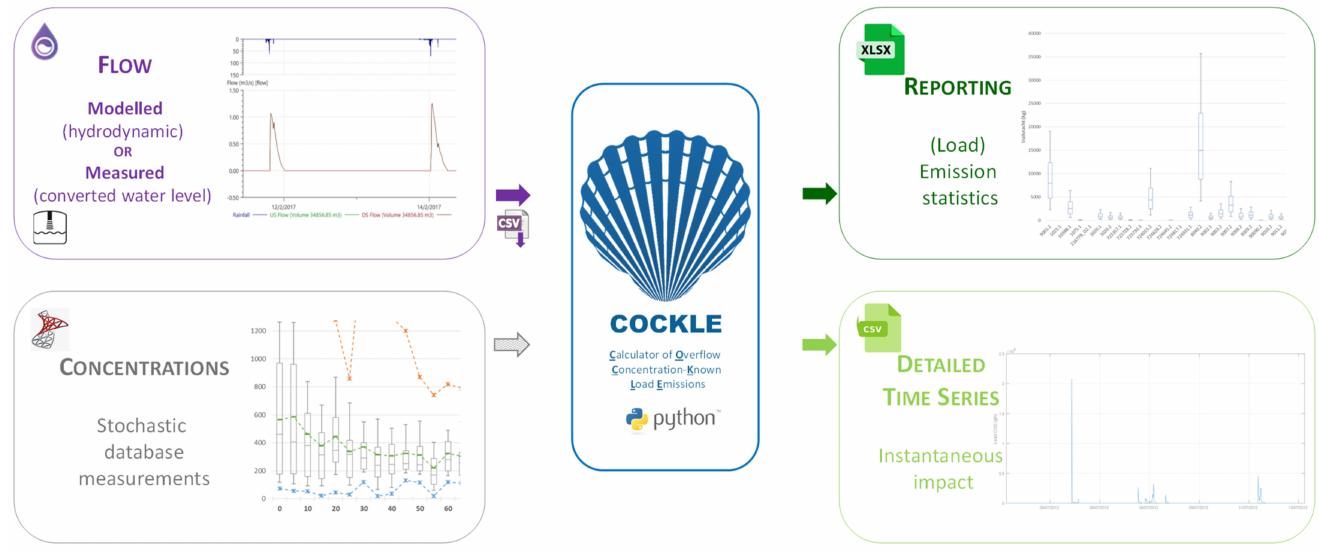
Figure 6. Cockle software with input ( left ) and output ( right